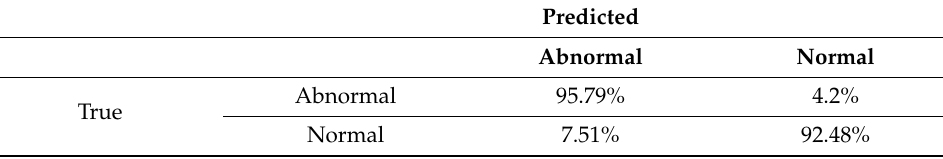
Table 8. Confusion matrix of the